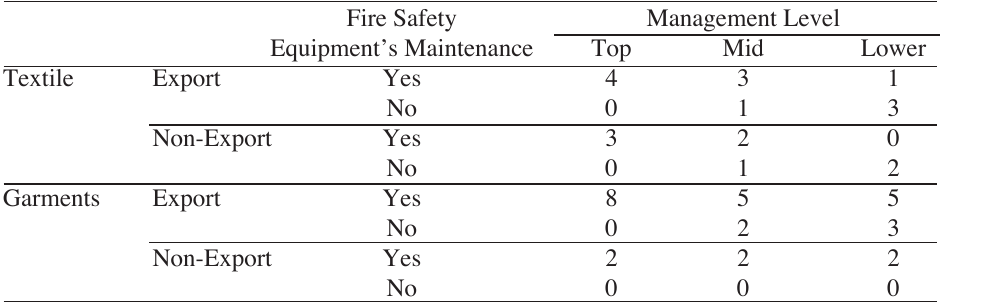
Management Positions vs. Fire Safety Equipment’s Maintenance